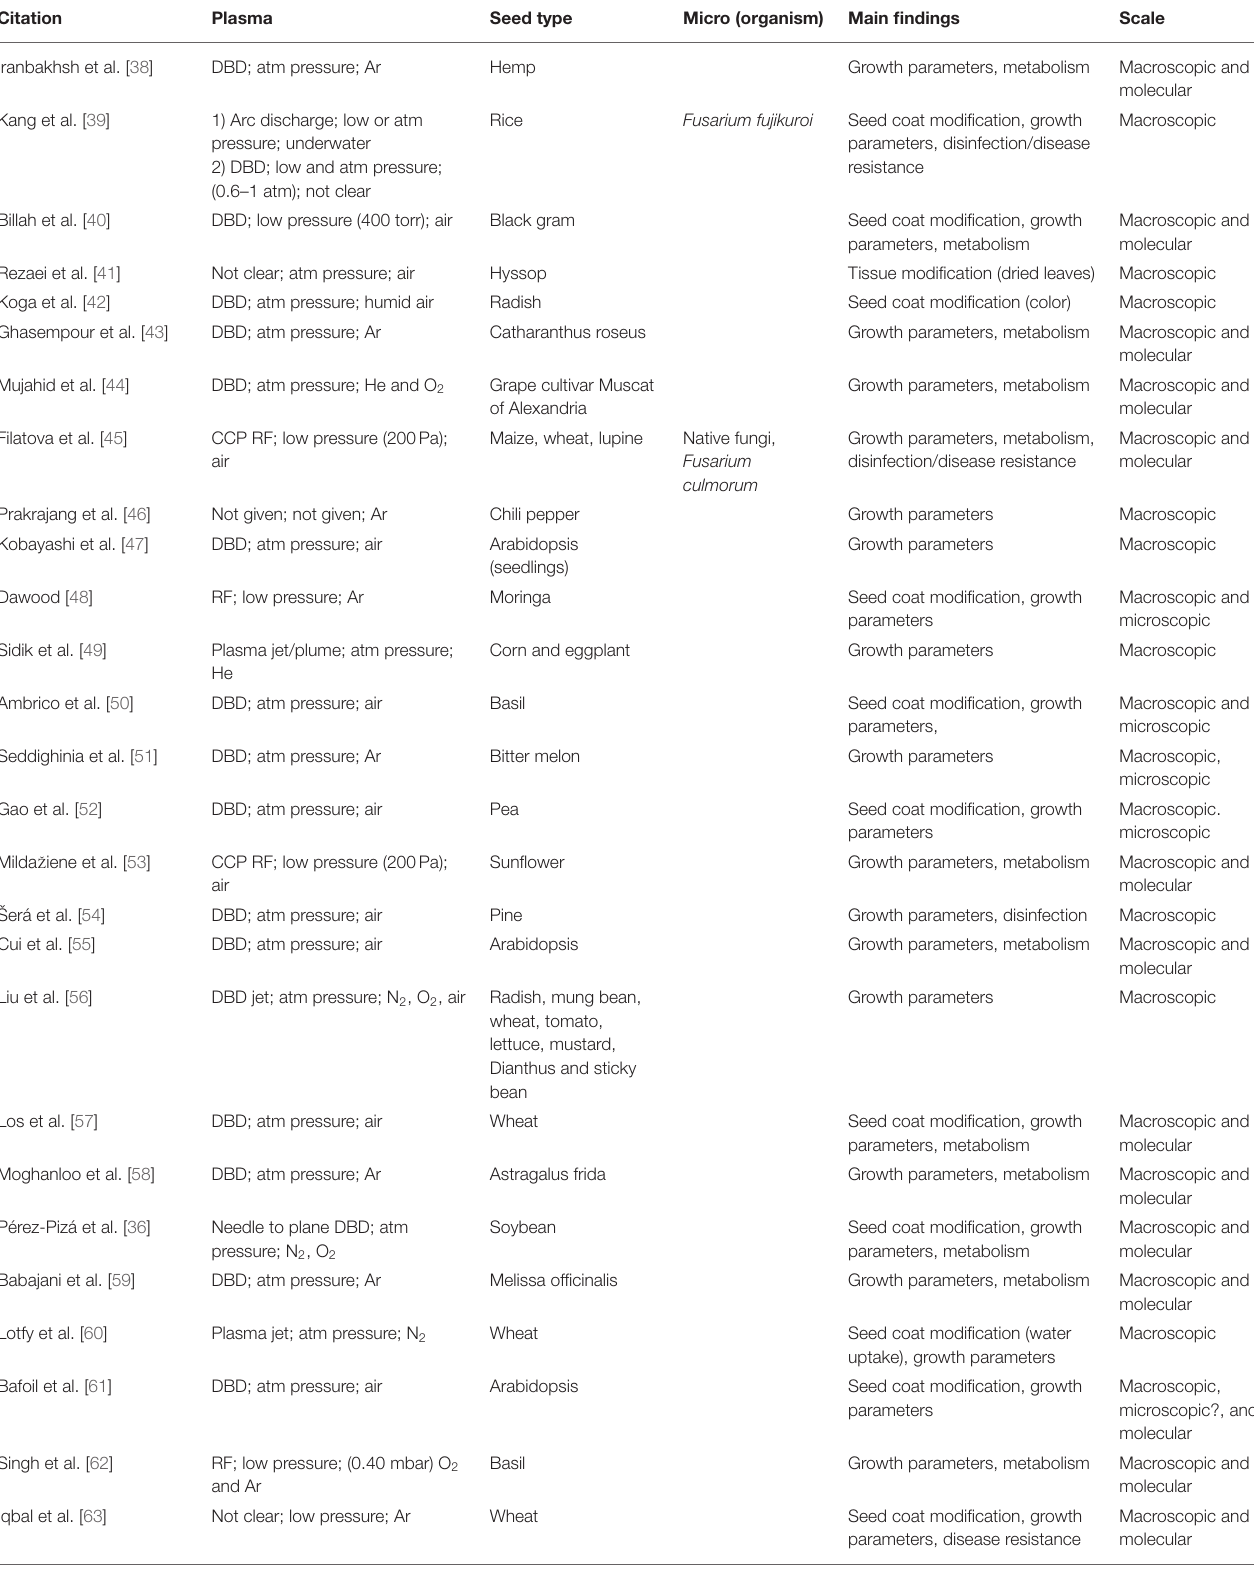
TABLE 2 | Collection of plasma-seed treatment